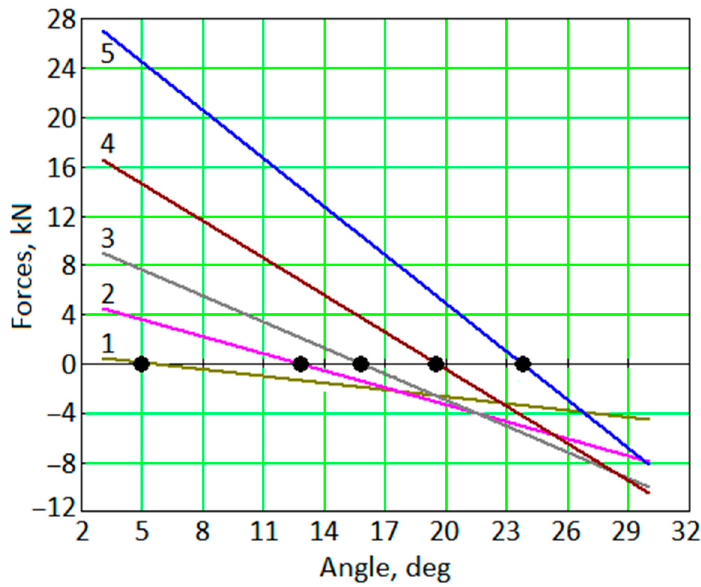
Figure 10. Dependencies of Q 21 ( α 21 ) [kN] on the displacement Δ [mm]: 1— Δ = 5 mm; 2— Δ = 10 mm; 3— Δ = 20 mm; 4— Δ = 25 mm; 5— Δ = 30 mm.